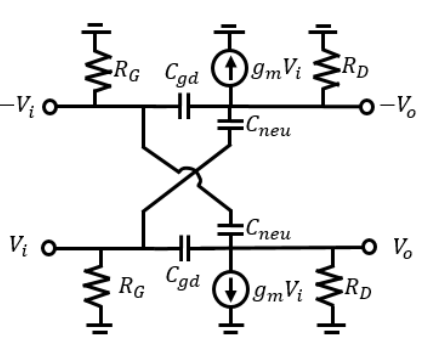
Figure 4. Small signal equivalent circuit with capacitive neutralization.